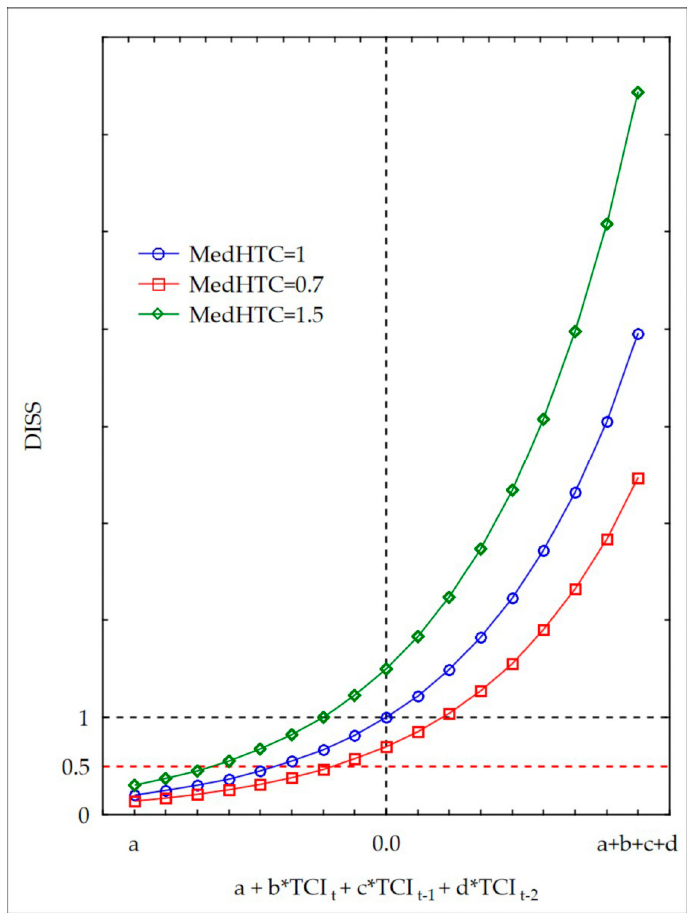
Figure 11. Comparison of Drought Information Satellite System (DISS) values for different MedHTC Comparison of Drought Information Satellite System (DISS) values for di ff erent conditions. MedHTC